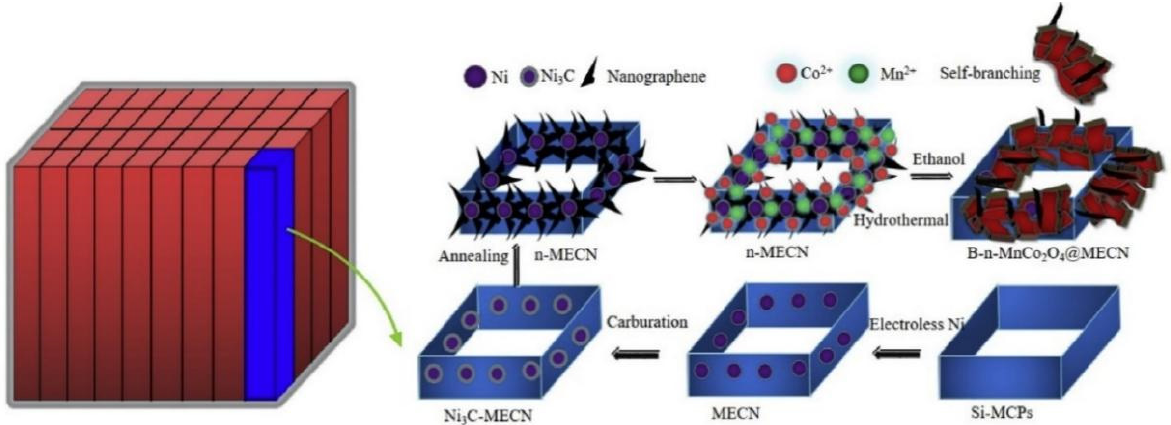
Figure 10. Schematic illustration of preparation steps of the MnCo 2 O 4 deposit on the nanographene modified MECN for Na-ion batteries. Reproduced with permission [79]. Copyright 2020, Elsevier.